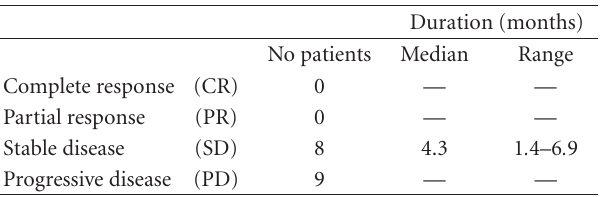
Table 6: Confirmed response ( n = 17 evaluable patients).